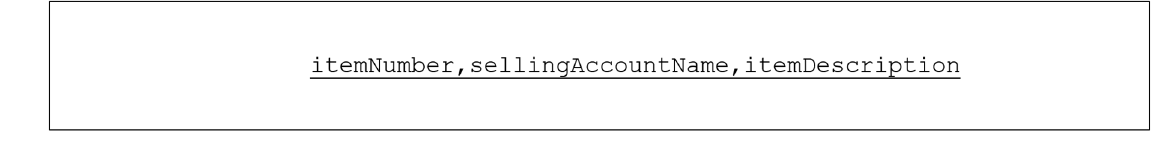
Figure 4. Structure of Listing Data from Marketplace.